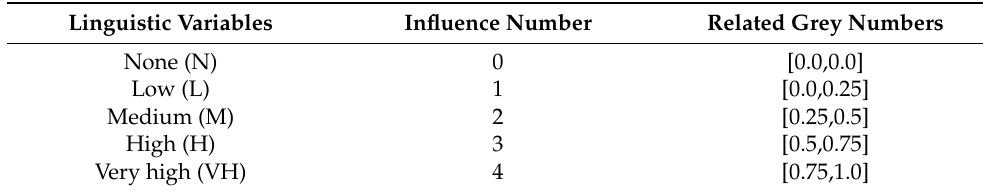
Table 4. Grey linguistic